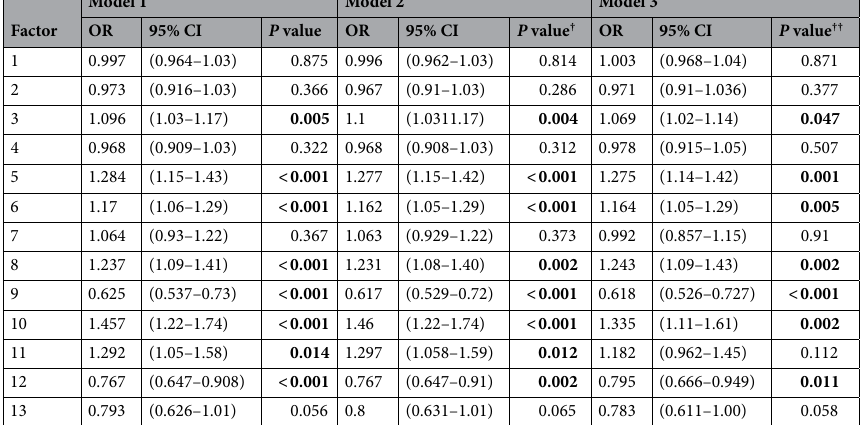
Table 3. Crude and adjusted odds ratios (OR) and their 95% confidence intervals (CI) of the extracted factors analyzed the relationship between metabolite patterns and diabetes incidence. P value, crude model (Model 1). P value † , adjusted by blood pressure (Model 2). P value †† , adjusted by blood pressure and lipid profile (HDL-C, cholesterol, triglyceride) (Model 3). Significant values are in